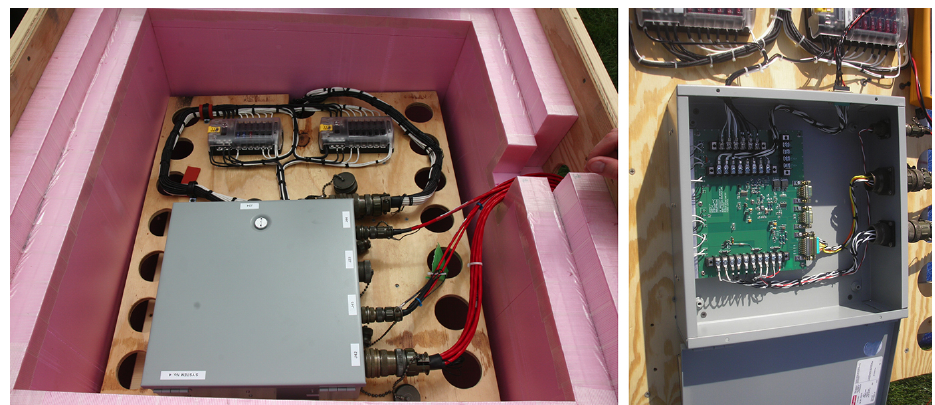
Figure 9. (left) Power electronics box and fuse panel installed on top of the batteries in the battery box. (right) Printed circuit board in the power electronics box.